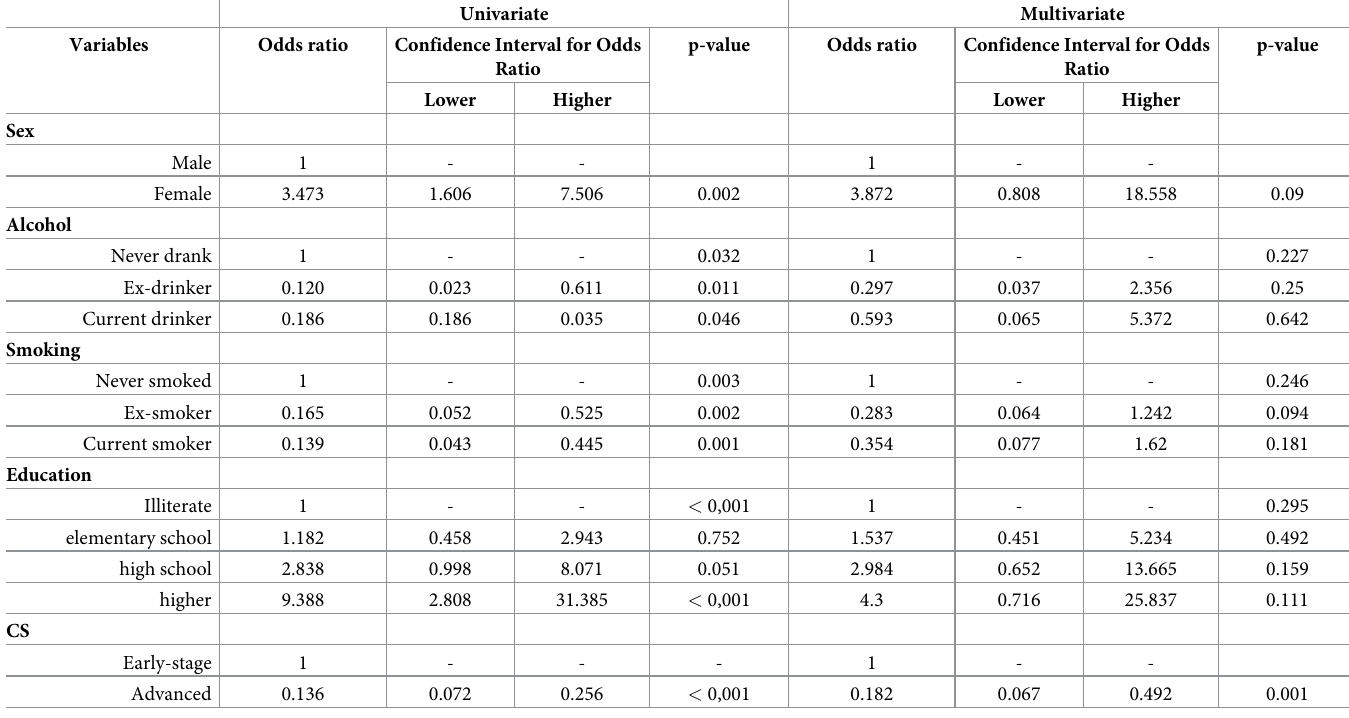
Table 3. Model of the univariate and multivariate analysis of sociodemographic data based on p16